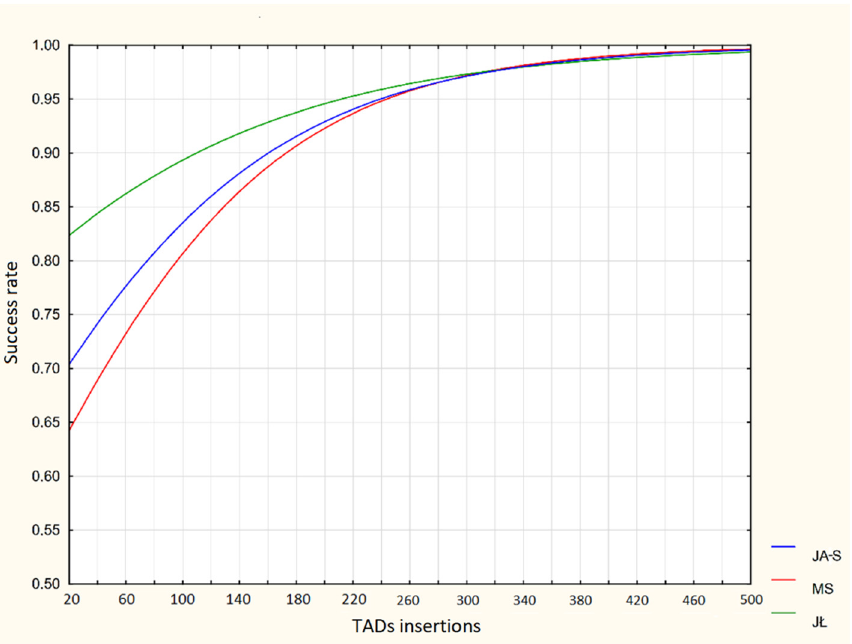
Figure 2. Each operator’s learning curves in TAD insertion—logistic regression model.